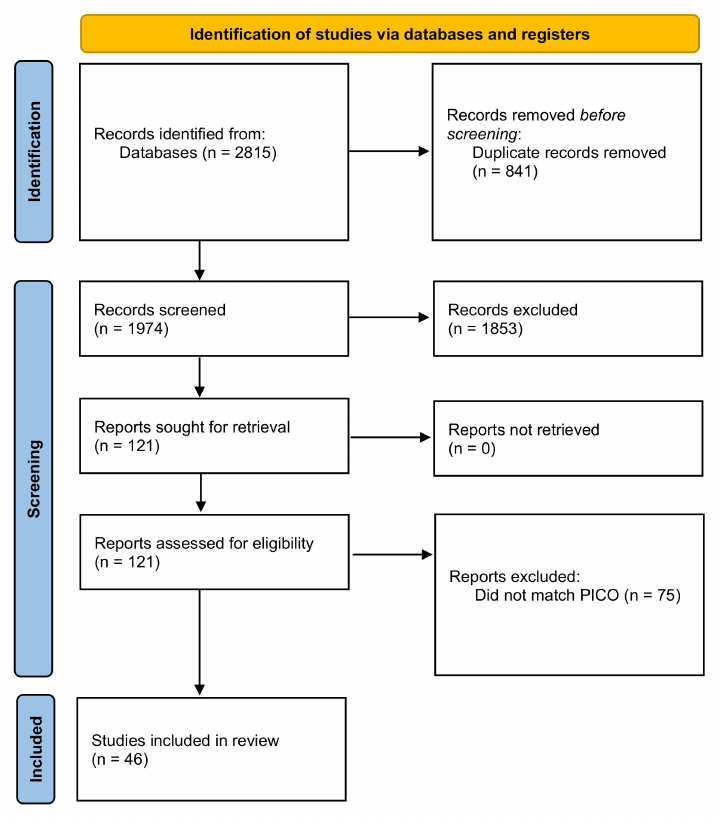
Figure 1. Study selection